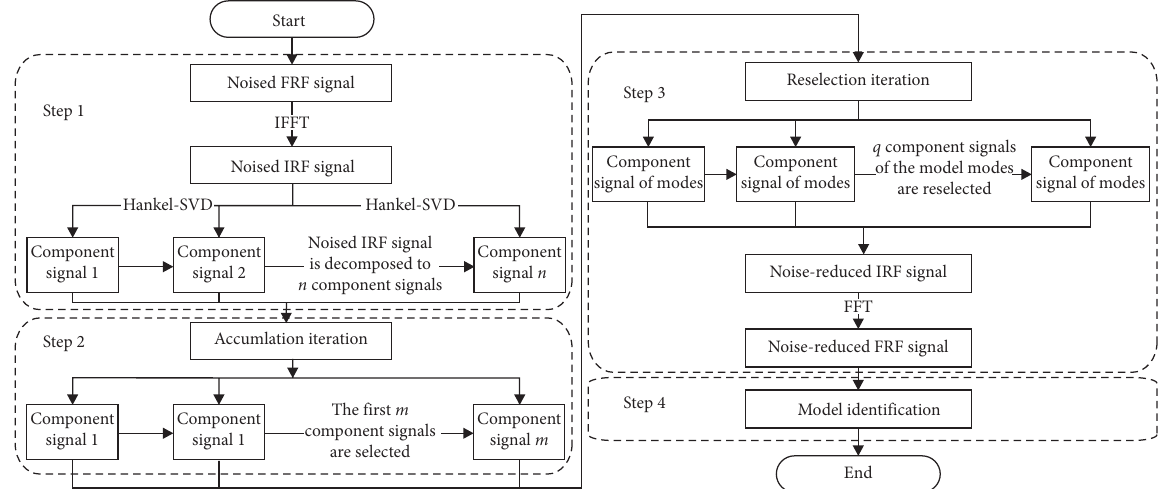
Figure 1: The flowchart of the proposed method.